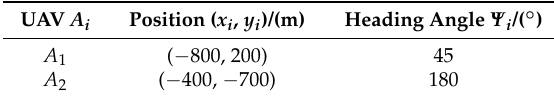
Table 4. The initial settings of the two UAVs in Scenario